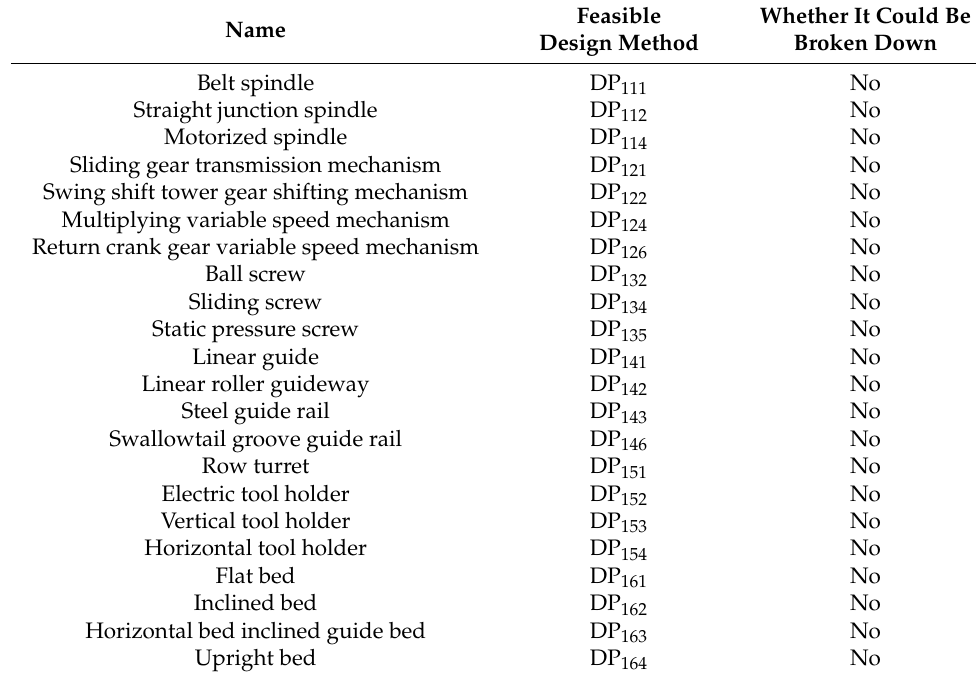
Table 6. List of terminal nodes for FR 11 , FR 12 , FR 13 , FR 14 , FR 15 , and FR 16.